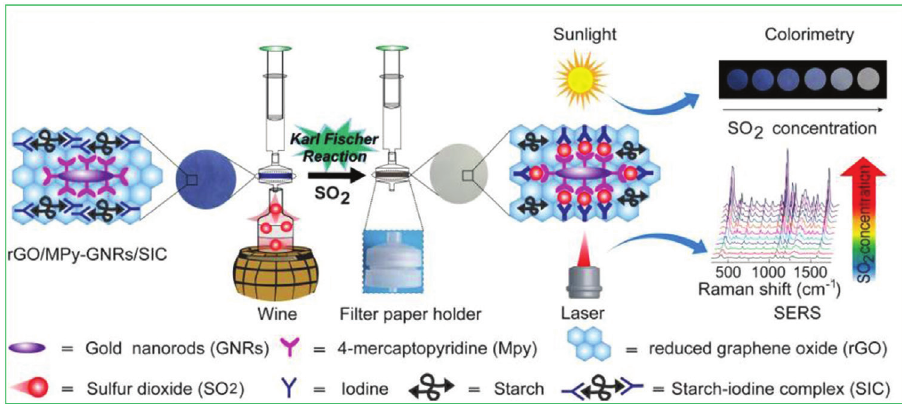
Figure 2: Schematic illustration of the structure of the rGO/MPY-GNRs/SIC-filter substrate for head-sampling and subsequent colorimetric and SERS detection of of SO in wine. Reproduced with permission from Ref. [43]. Copyright: 2018 American Chemical 2